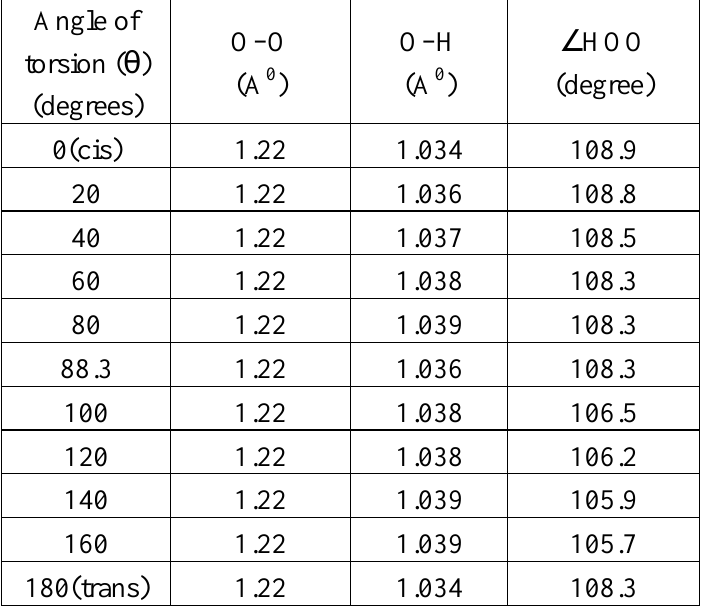
O as a function of dihedral angles. 2 2